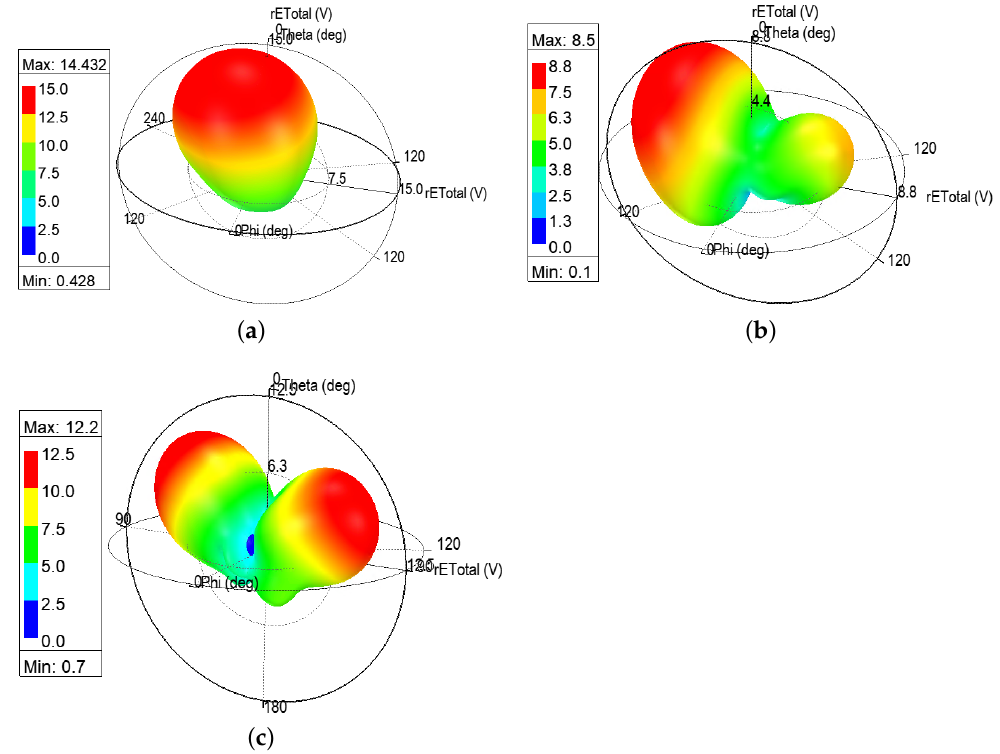
Figure 12. Electric field 3D polar plot for cylinder radius of 20 mm. ( a ) Electric field 3D polar plot at 5.8 GHz; ( b ) Electric field 3D polar plot at 6.2 GHz; and ( c ) Electric field 3D polar plot at 8.4 GHz. Regarding the case of cylinder radius 50 mm and bending angle 7.2 ◦ , the 3D polar plots of E-field are demonstrated in Figure 13a–c. The general patterns of E-field 3D polar plot at 5.8 and 8.4 GHz remain similar to those of previous case where cylinder radius is 20 mm. A significant pattern change happens at 6.2 GHz, where most of the E-field concentrates above the radiating patch, pointing along the + z -axis, but it also shows a tendency to split into two lobes. The maximum E-field strengths were measured as 15.2, 10.6, and 14.6 V/m, respectively. At the 6.2 GHz band, the antenna radiates relatively weaker electromagnetic